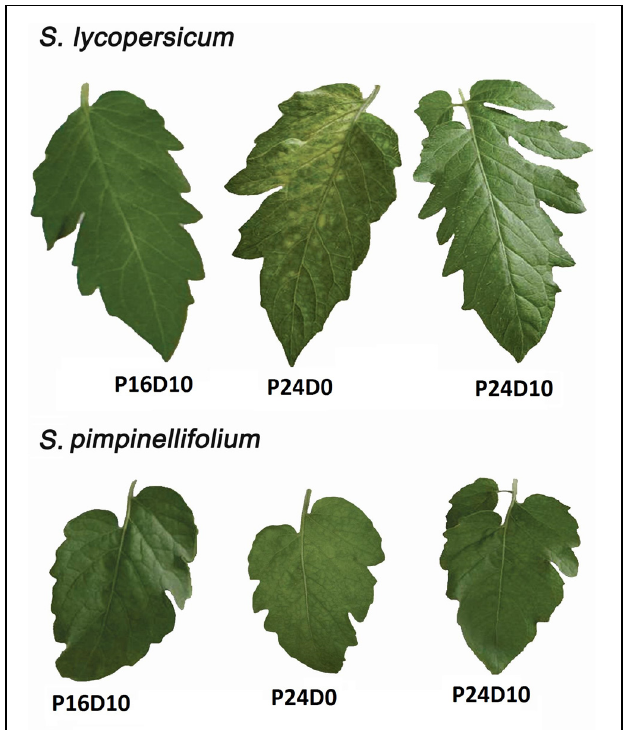
FIGURE 1 | Leaflets of Solanum lycopersicum and S. pimpinellifolium grown in control (P16D10), continuous light with constant temperature (P24D0) and continuous light with variable temperature (P24D10) conditions. The photographs were taken after 12 days of start of CL